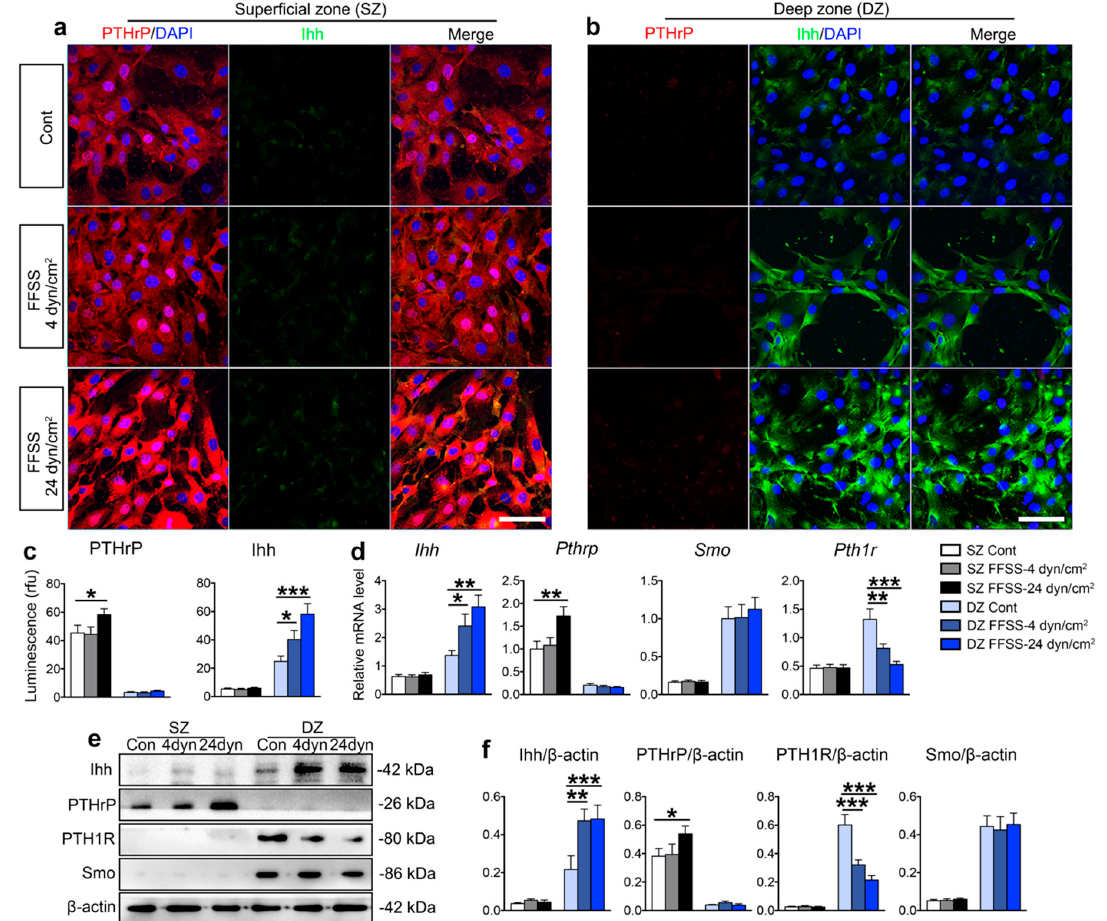
Figure 3. Ihh and PTHrP signaling changes in the superficial and deep zone cells under FFSS. ( a , b ) Immunofluorescence staining of PTHrP and Ihh in the cultured superficial ( a ) and deep zone ( b ) cells obtained from the mandibular condylar cartilage of the 3-week-old rats. FFSS was applied at 4 and 24 dyn / cm 2 . Cont: Cells were not treated by FFSS and taken as controls ( c ) The quantification of immunofluorescence intensity for PTHrP and Ihh. ( d – f ) Comparison of mRNA ( d ) and protein expression ( e , f ) of Ihh, PTHrP, Smo, and PTH1R. Magnification, 400 × . Scale bar, 25 µ m. n = 3. Results are represented as the mean ± SD. * p < 0.05, ** p < 0.01, *** p < 0.001. 2.3. Suppressing Ihh Signaling Rescued FFSS and UAC Stimulated Chondrocytes Terminal Differentiation